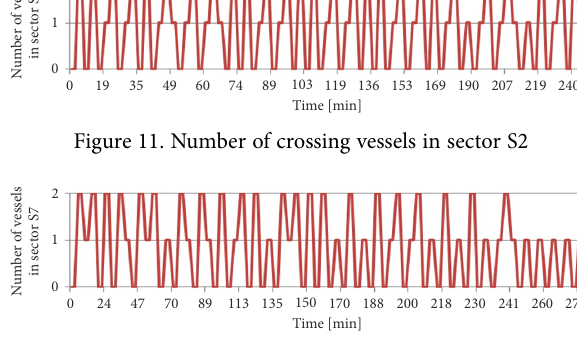
Figure 12. Number of crossing vessels in sector S7